Question: Describe this figure in one sentence.
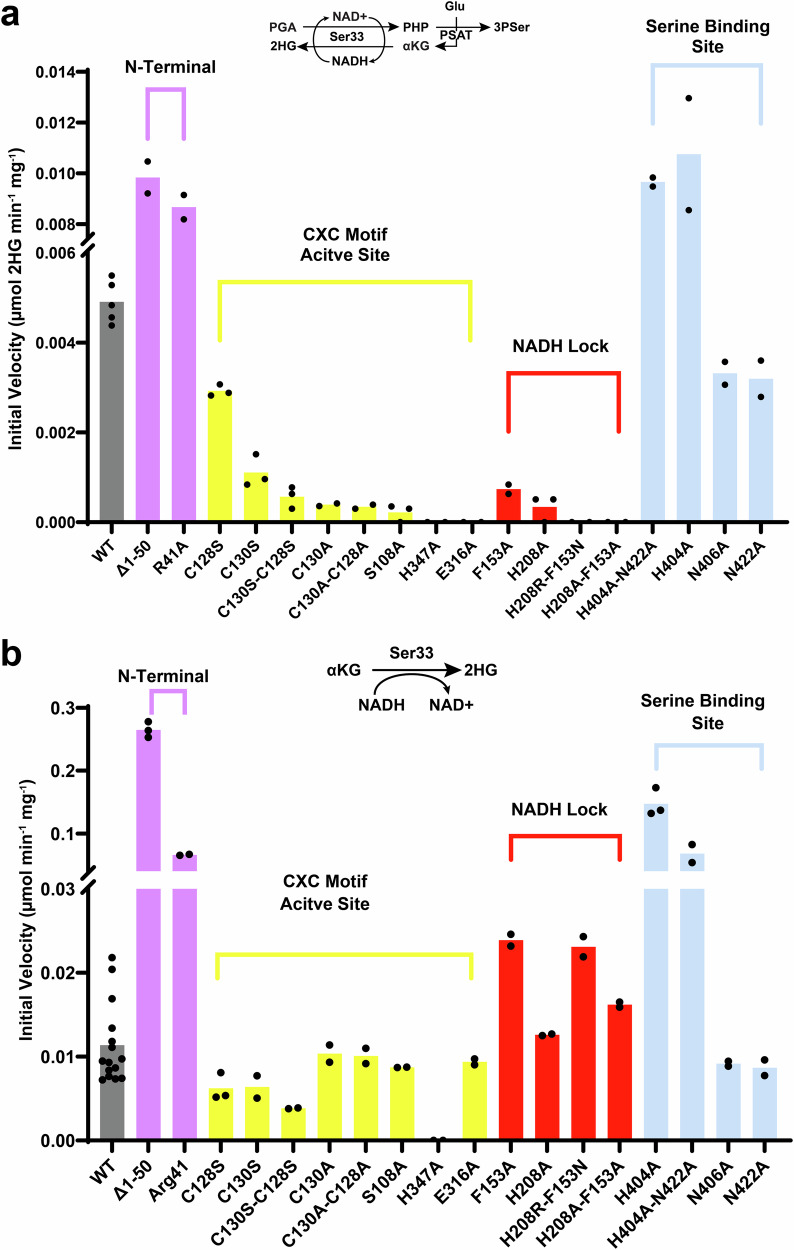
Answer: Transhydrogenase and αKG reductase activity of wild-type Ser33 and Ser33 variants. Based on the Ser33 structure, the indicated Ser33 variants and truncated proteins were selected, produced, purified, and functionally characterized. a The initial velocities of the transhydrogenase activity of wild-type Ser33 and Ser33 variants (40 μg/ml) were determined by measuring 2HG formation using LC-MS/MS. b The initial velocities of the αKG reductase activity of wild-type Ser33 (60 μg/ml) and Ser33 variants (120 μg/ml) were determined by monitoring the consumption of NADH spectrophotometrically at 340 nm. Data are shown as means of independent measurements and are represented by dots ( n = 2–3 for Ser33 variants; n = 5–15 for wild-type Ser33; Source data are provided as a Source Data file).